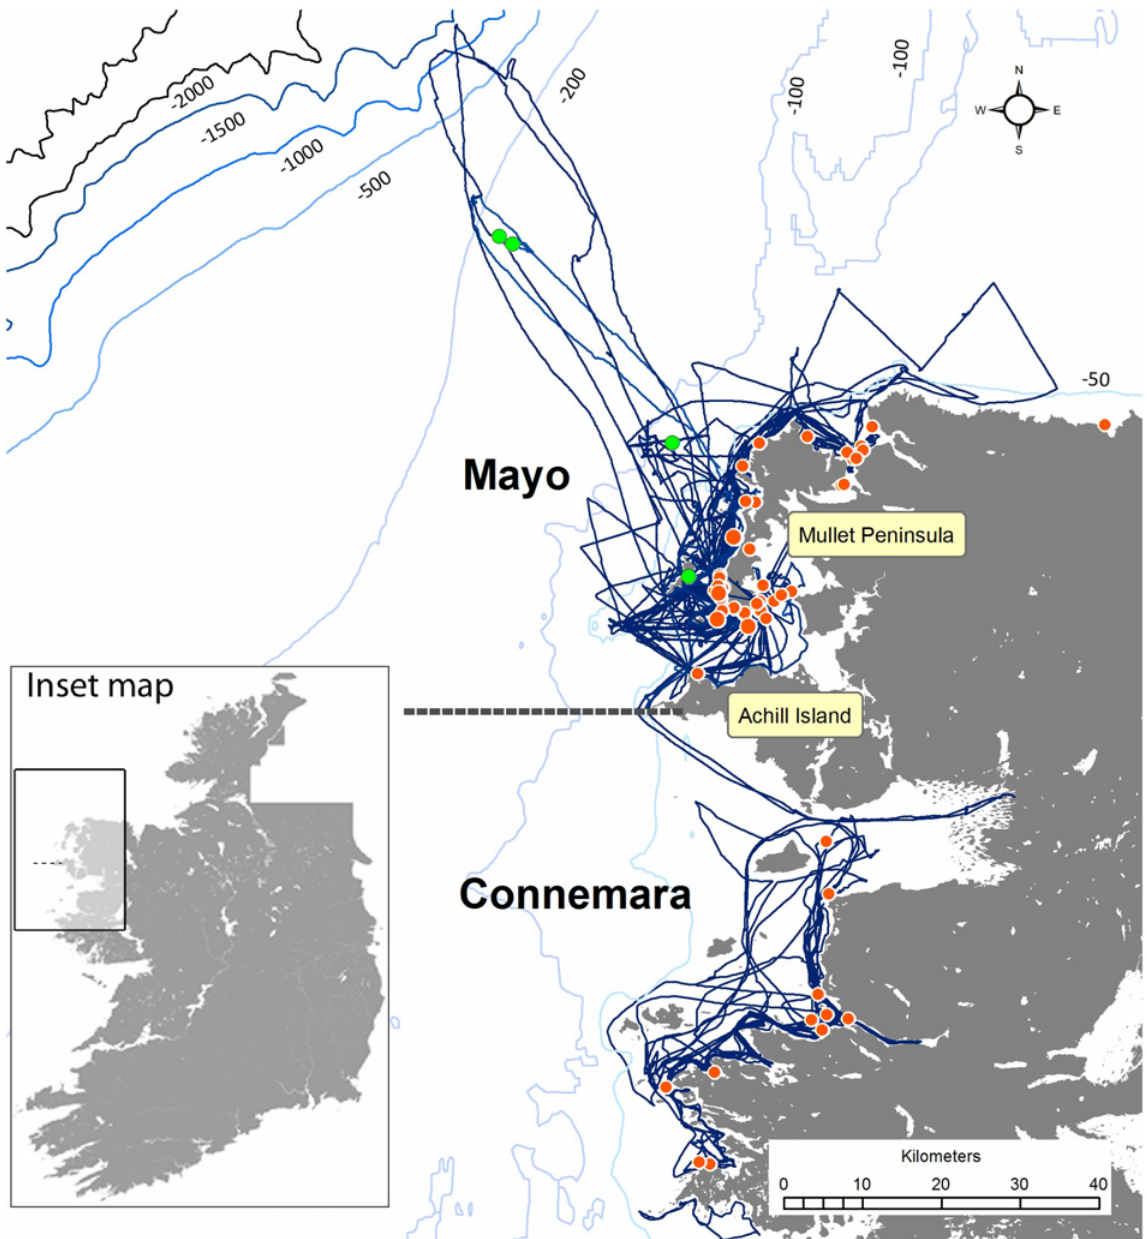
Fig 1. Survey effort and sighting locations of bottlenose dolphin group encounters. The black lines indicate survey effort in the two research areas off northwest Ireland, Mayo and Connemara. Sighting locations of bottlenose dolphin groups in inshore waters are indicated by red circles, encounters in offshore waters are indicated by green circles. The geological map of Ireland has been reproduced under an open-access license from the DECRN, and the Intellectual Property Right and Copyright of the Geological Service Ireland. The bathymetry is reproduced from GEBCO, and extracted from the GEBCO Digital Atlas published by the British Oceanographic Data Centre on behalf of the IOC and IHO, 2003.